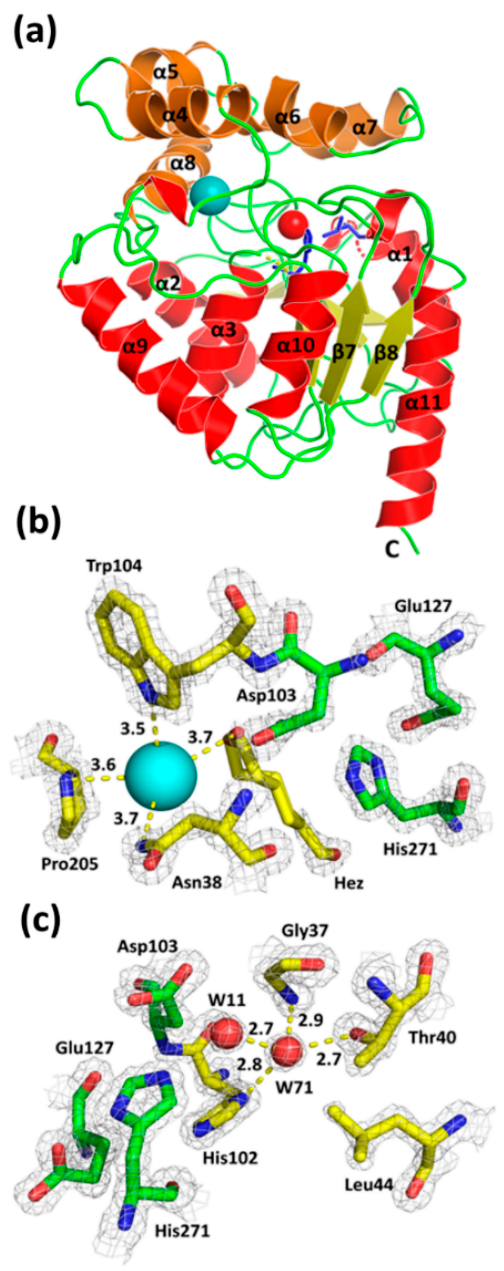
Figure 3. The overall structure of DbeA ∆ Cl ( a ), close-up view of the canonical DbeA ∆ Cl active site ( b ) and second halide-binding site ( c ). The 2F o -F c electron-density map contoured at 2 σ is shown in grey ( a ) C α ribbon trace shows elements of the protein secondary structure. The α -helices are coloured red for the main domain and brown for the cap domain; β -strands are coloured yellow; loops are shown in green; iodide ion is presented as a cyan sphere, water molecule (W71) is shown as a red sphere; the two point substitutions Ile44Leu + Gln102His introduced into DbeA are highlighted as blue sticks. ( b ) The iodide ion in the active site is presented as a cyan sphere with coordination interaction distances in Å and highlighted by yellow dashed lines; hexanediol (Hez) (shown in two alternative conformations) and amino acids Asp103, Trp104, Pro205 coordinating the iodide ion are shown as sticks with carbon atoms coloured yellow. Carbon atoms of catalytic triad are highlighted in green. ( c ) The water molecules W11 and W71 are presented as red spheres; amino acids coordinating water molecule W71 are shown as sticks with carbon atoms coloured in yellow with and interactions with distances in Å shown by yellow dashed lines. Water molecule W71 is located in second-halide binding site.